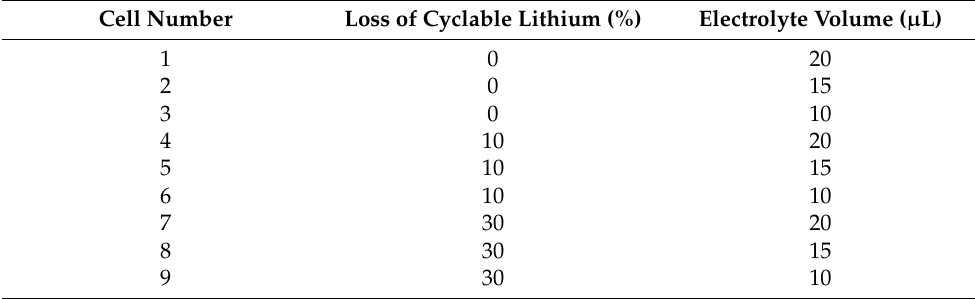
Table 1. Cells used to test the cyclable lithium loss and electrolyte depletion of LIB cells. Cell Number Loss of Cyclable Lithium